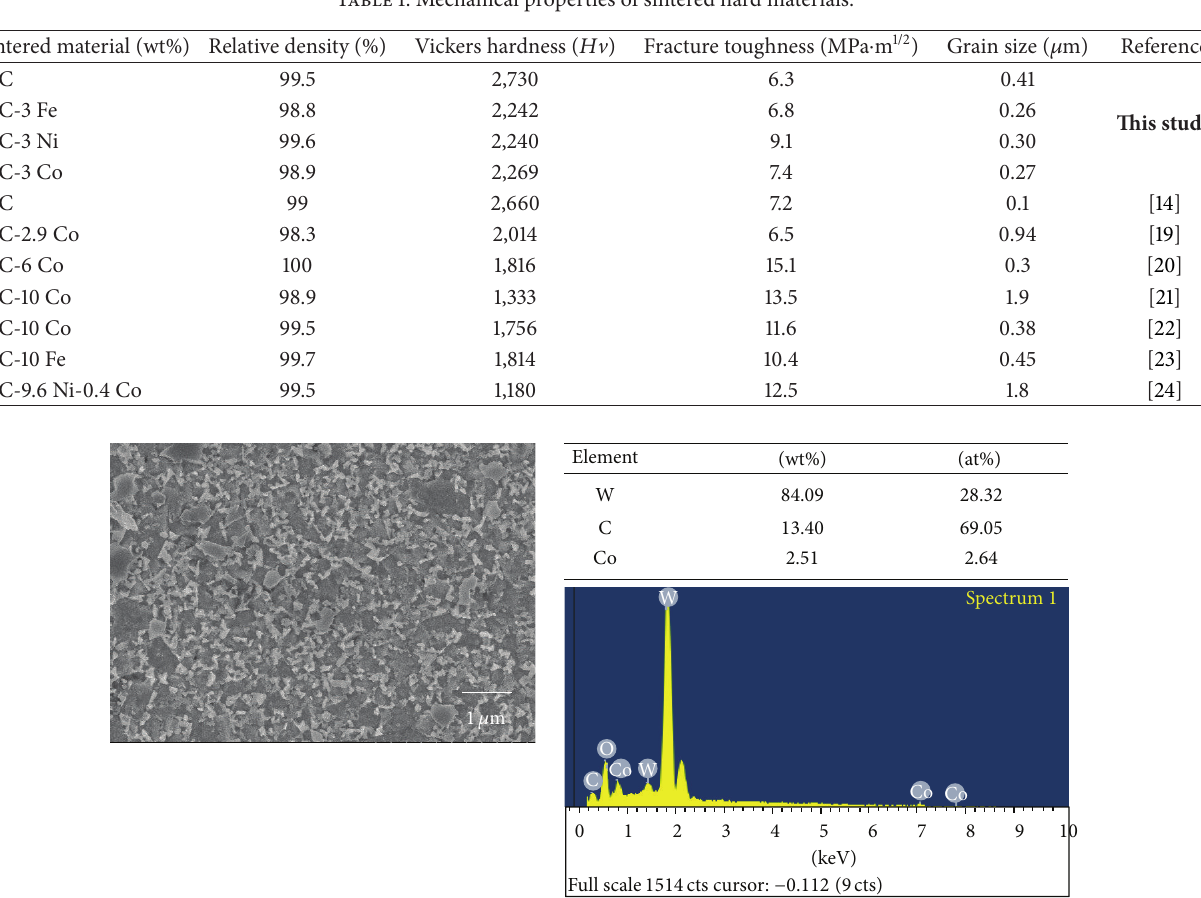
Table 1: Mechanical properties of sintered hard materials.